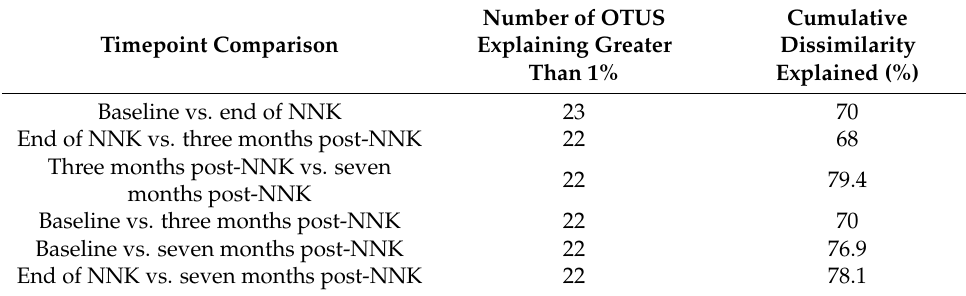
Table 2. Gprc5a − / − lung microbiome SIMPER